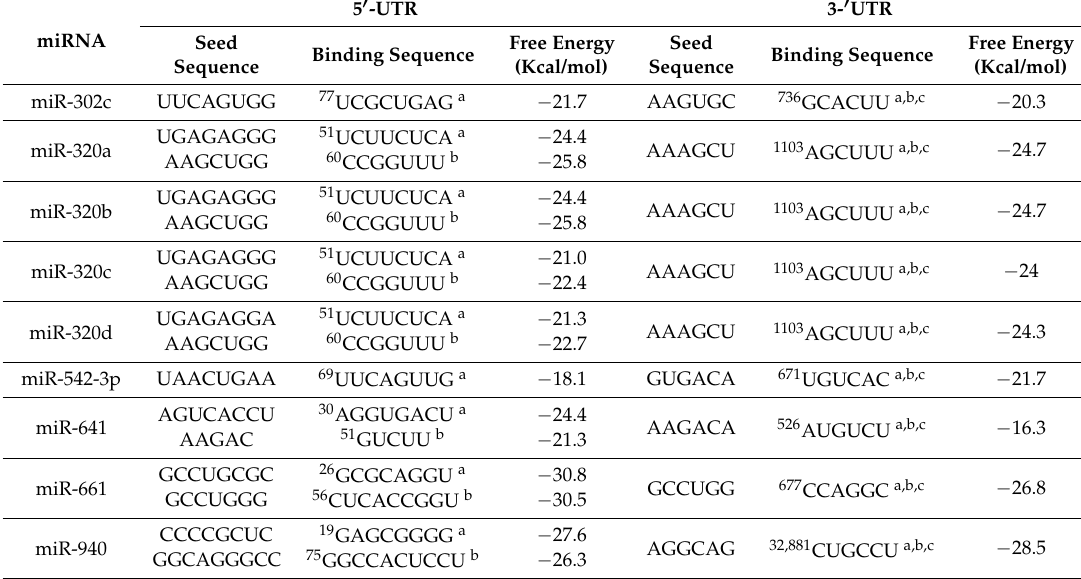
Table 2. Novel candidate microRNAs (miRNAs) binding sites at 5 (cid:48) -untranslated region (UTR) and 3 (cid:48) -UTR of MHC class I chain related protein B